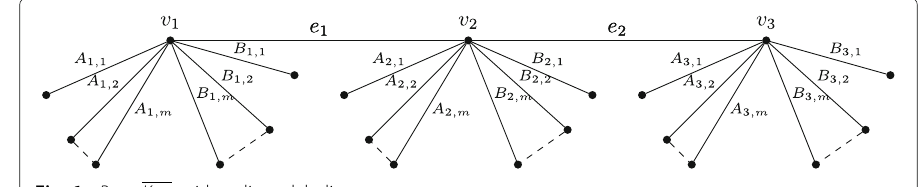
Fig. 6 P 3 (cid:4) K 2 m with ordinary